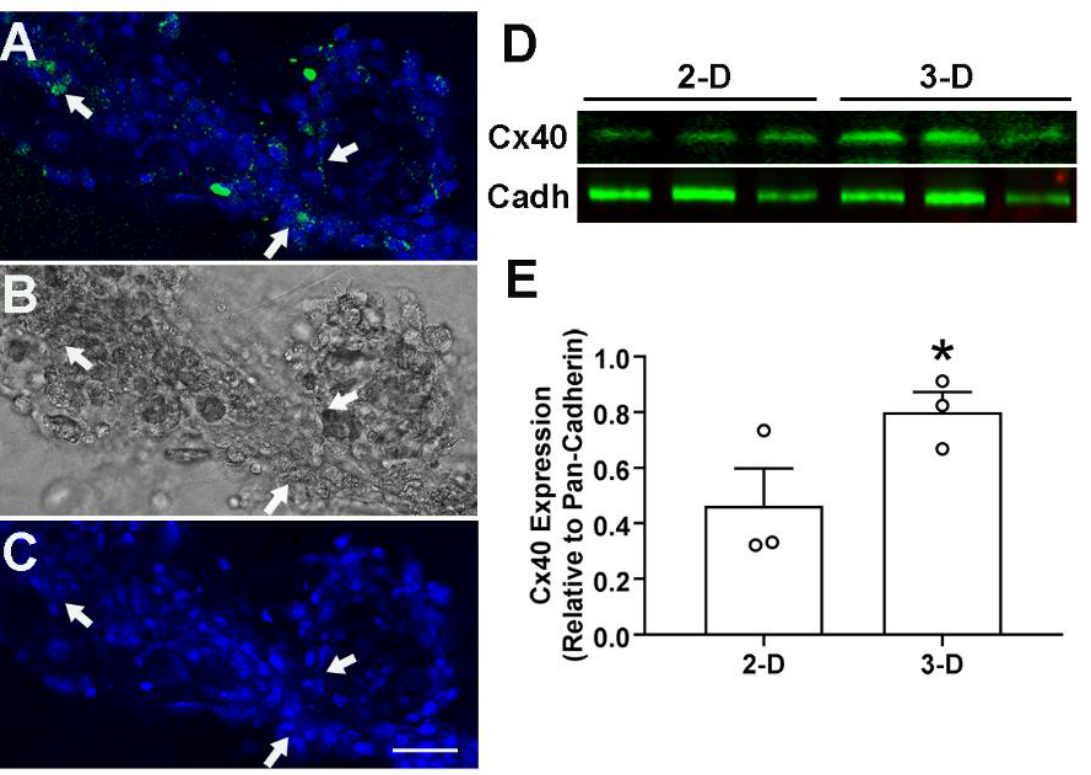
Figure 3. Analysis of Cx40 expression (ventricular conduction system (VCS) marker protein) in 2-D and 3-D cultures of E11.5 ventricular cells. ( A ) Representative merged confocal image of 3-D cultures stained with Cx40 antibodies (green, arrows) and Hoechst nuclear dye, ( B , C ) The same field was imaged under brightfield ( B ) or Hoechst fluorescence alone ( C ). A–C: Arrows indicate the rel- ative location of Cx40 expressing cells, Bar = 50 μm, ( D ) Western blot analysis of Cx40 in membrane lysates extracted from three independent samples each from E11.5 ventricular cells cultured in 2-D (N = 3) and 3-D (N = 3) conditions for 8 days, Lower panel represents pan-cadherin (Cadh) expres- sion levels which was used to normalize the relative levels of Cx40, ( E ) Signal intensities for samples shown in panel D were quantified using the acquisition software from Odyssey DLx (LI-COR) and Cx40 expression levels relative to the pan-cadherin (Cadh) were shown. N = 3 independent extrac- tions for both 2-D and 3-D cultures. Each bar represents mean ± SEM. Open circles represent indi- vidual data points for each group. * p < 0.05 for 2-D Vs. 3-D, Student’s unpaired t -test.